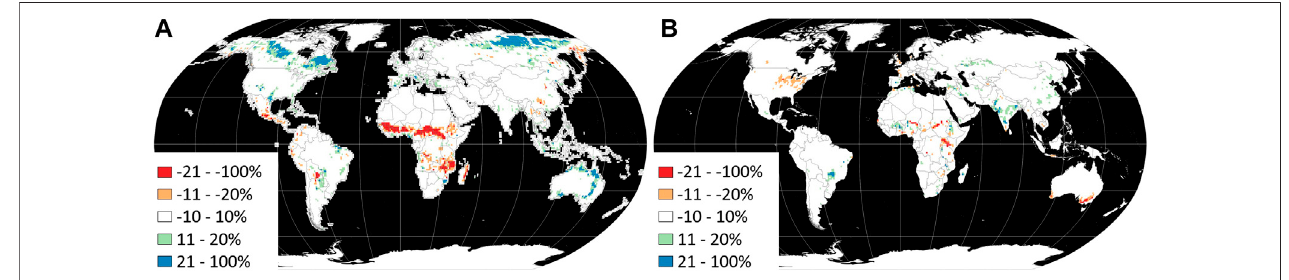
FIGURE 11 | LCLU class area difference between ESA WorldCover 2020 and the year 2020 thematic map for each 1 × 1 ° grid cell. Blue colors represent lower estimatesoftheclassareainournewmaprelativetoWorldCover,andredcolors – higher estimatesinourmap(inpercentofthecellarea). (A) Forestextent; (B) cropland extent.